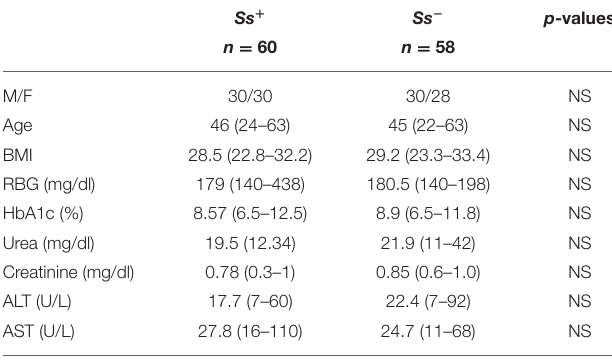
TABLE 1 | Demographic and biochemical